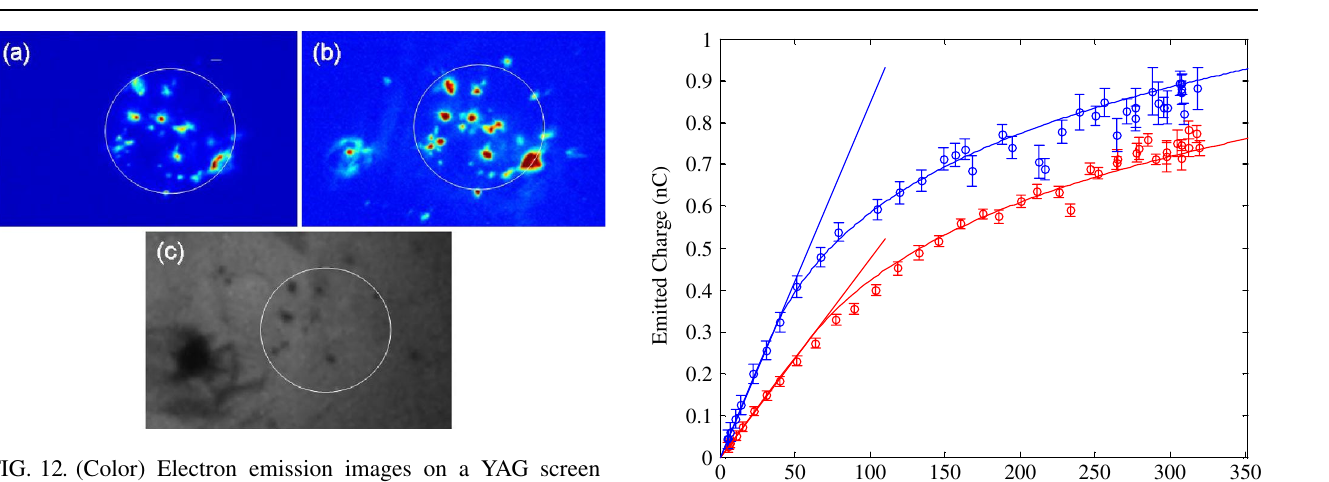
FIG. 12. (Color) Electron emission images on a YAG screen 1.4 m from the cathode, (a) and (b), taken on June 23, and images of the cathode taken using a white light source and camera, (c), taken on June 20. Image (a) is taken with the laser iris set for a 1.3-mm spot diameter and image (b) is taken with the iris fully open. The circle outlines the nominal 1.3-mm diameter laser illumination